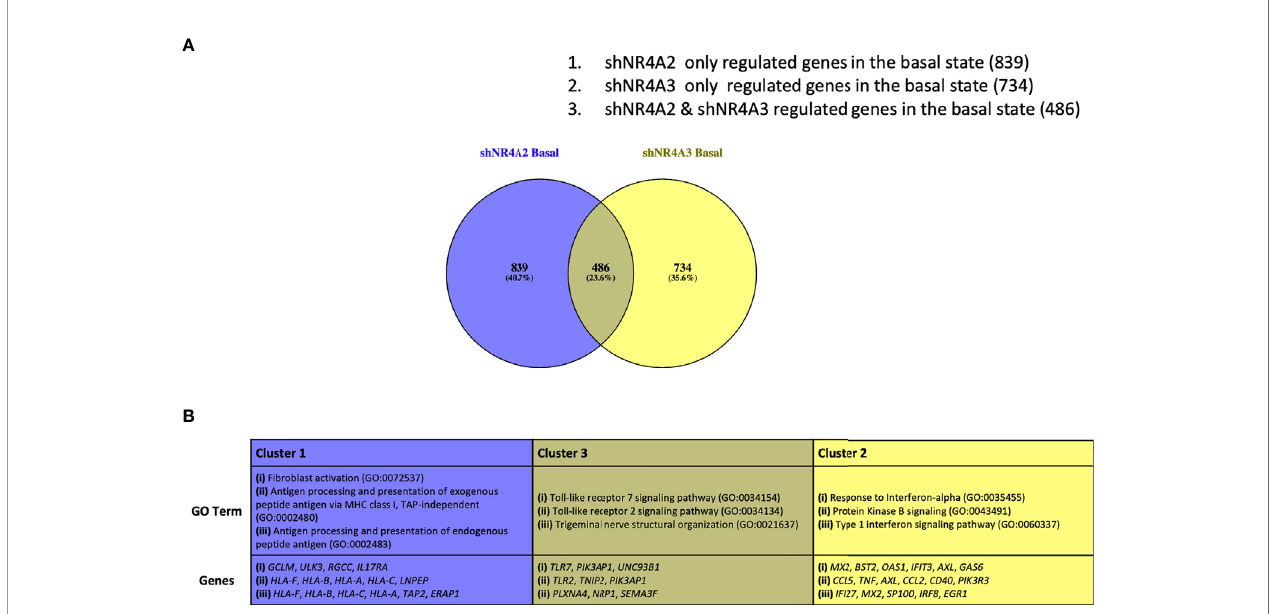
FIGURE 5 | Analysis of gene clusters regulated by NR4A2 alone, NR4A3 alone and by both NR4A2 and NR4A3 . Venn diagram outlining clusters of genes regulated by NR4A2 alone (cluster 1), NR4A2 and NR4A3 (cluster 2) and NR4A3 alone (cluster 3) from RNA-seq analysis using a threshold of p-adj </=0.05 for statistical signi fi cance (A) . Table describing the top 3 most enriched GO terms in genes associated with clusters 1-3 (top panel) in addition to the statistically signi fi cantly expressed genes in those clusters associated with the GO terms (bottom panel) (B)